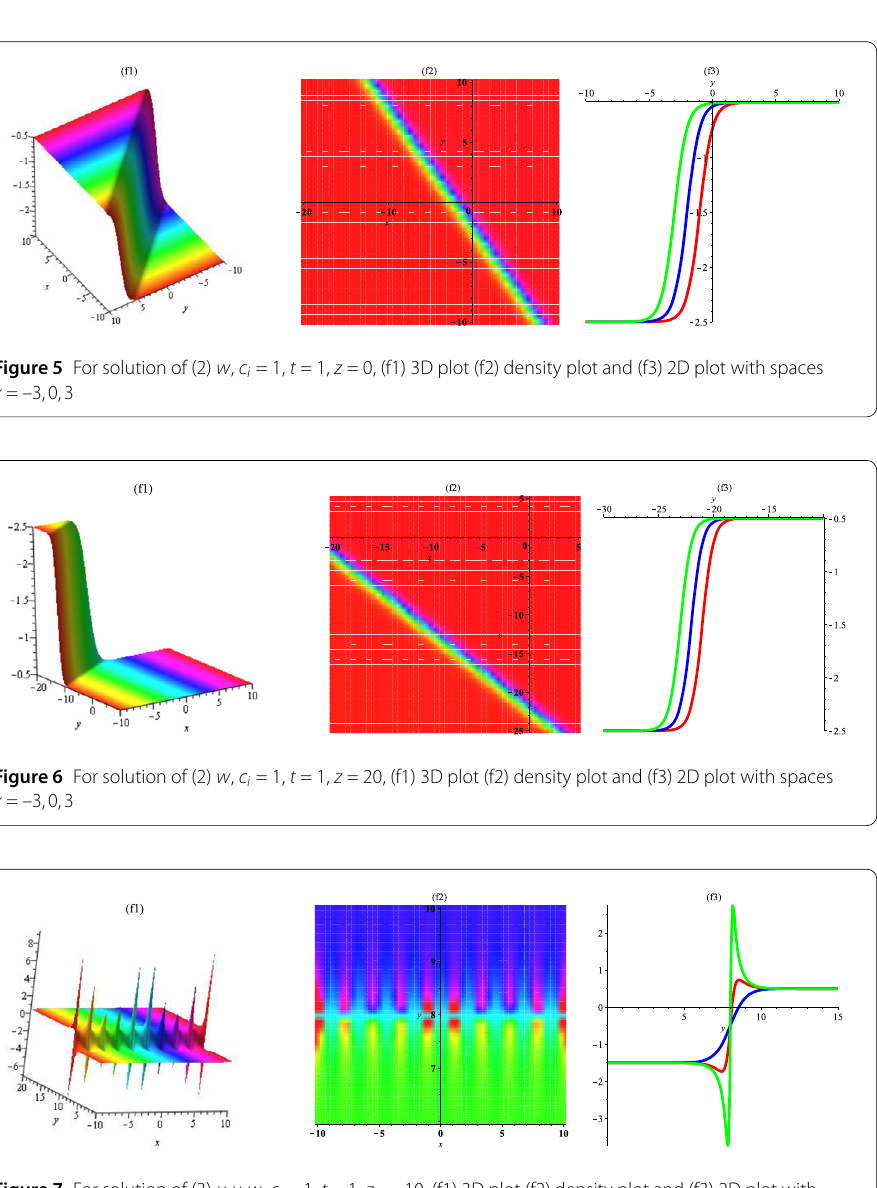
Figure 7 For solution of (3) u , v , w , c i = 1, t = 1, z = –10, (f1) 3D plot (f2) density plot and (f3) 2D plot with spaces x =